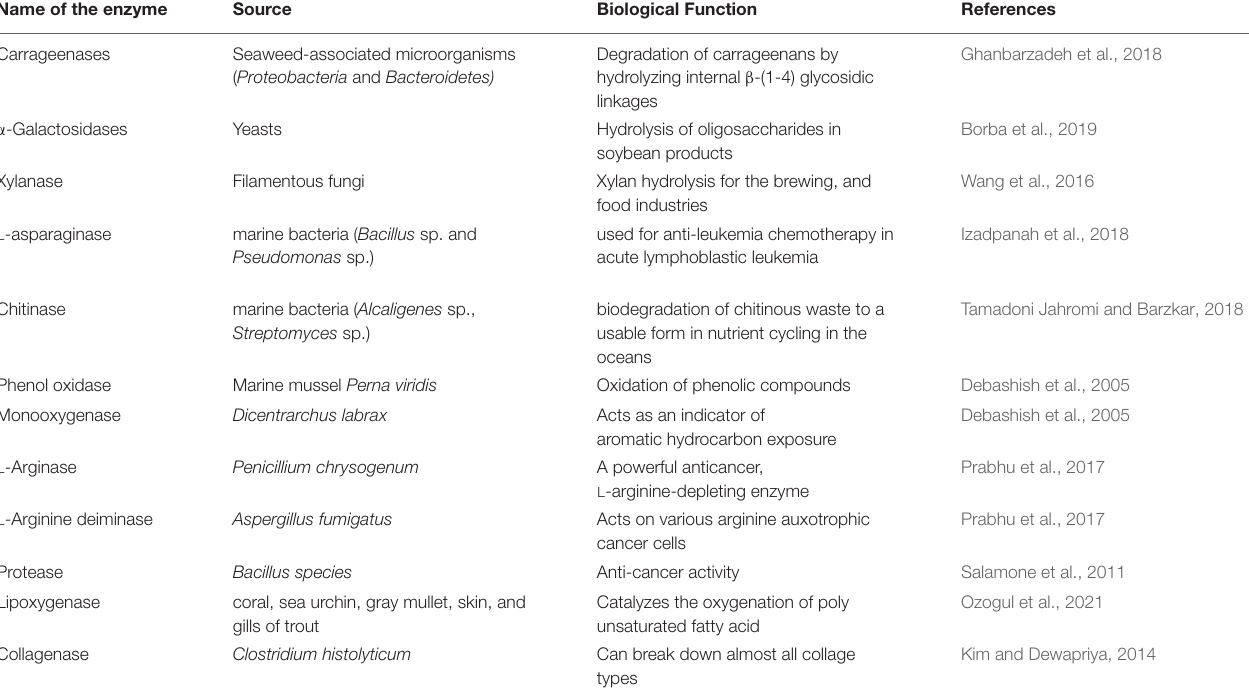
TABLE 3 | Various marine enzymes, their source, and biological